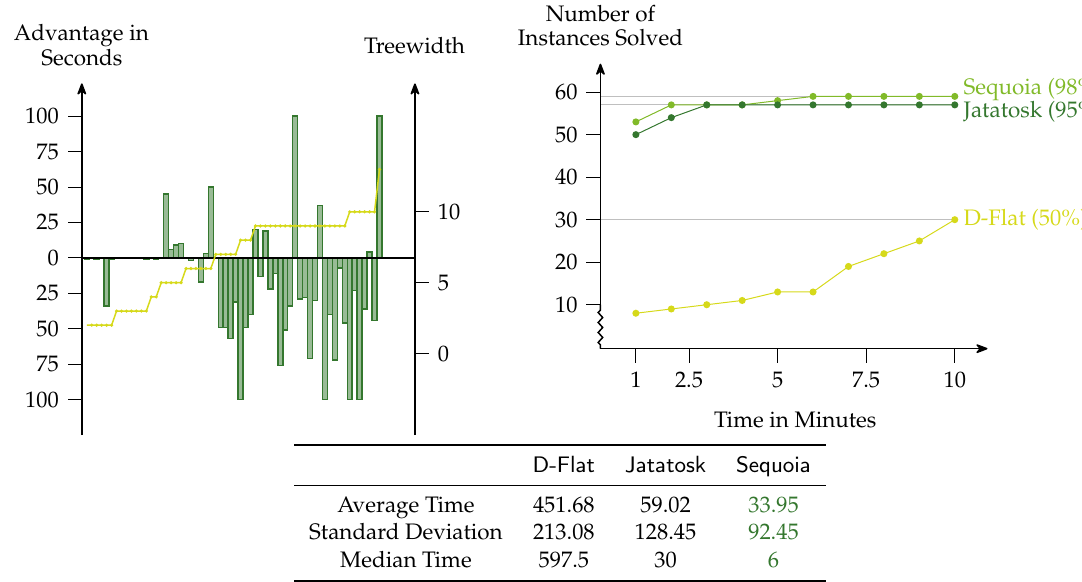
Figure 3. Experiment for the VERTEX - COVER